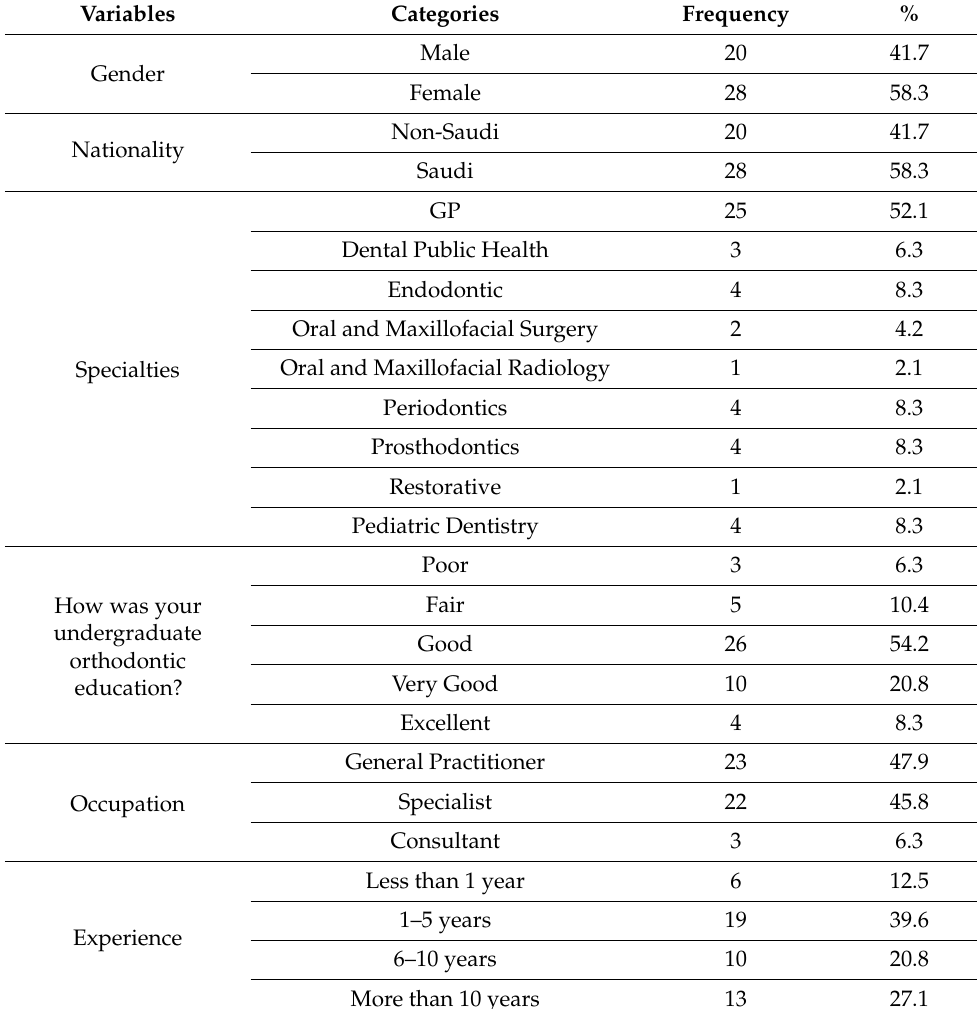
Table 2. Respondents’ characteristics ( n = 48).